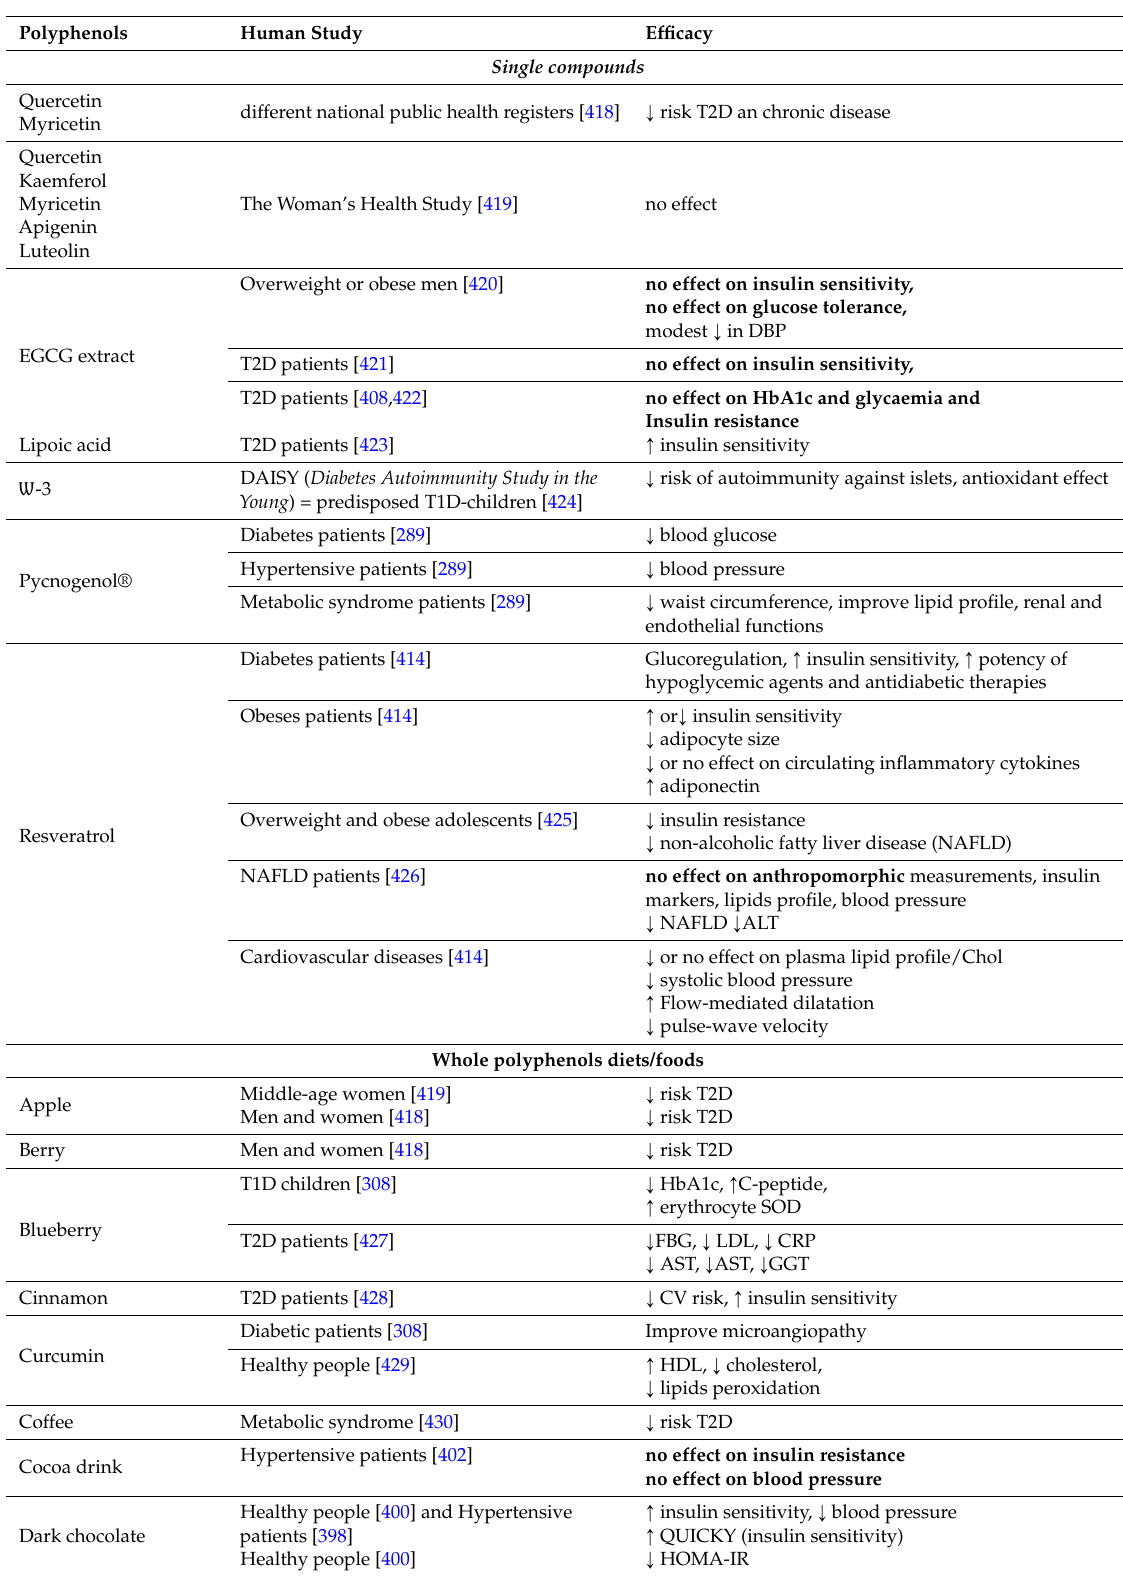
Table 6. Beneficial effects of several polyphenol-rich natural sources on Human cardio-metabolic diseases.